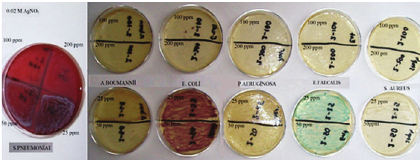
Figure 10: Antibacterial activity of chitosan-Ag nanoparticle mate- rials synthesized with 0.06 M AgNO 3 .